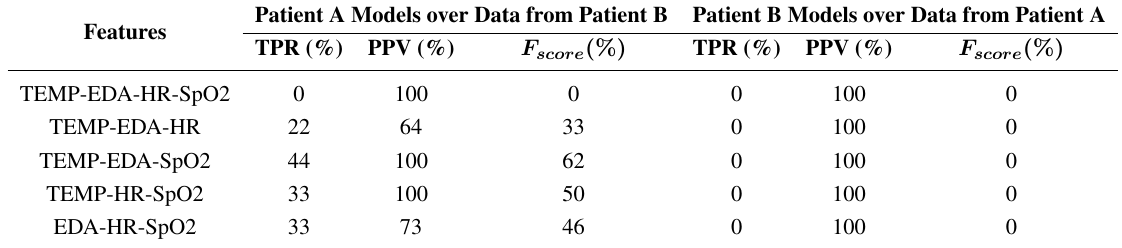
Table 6. Generalization of models for other patients for the reference fit of